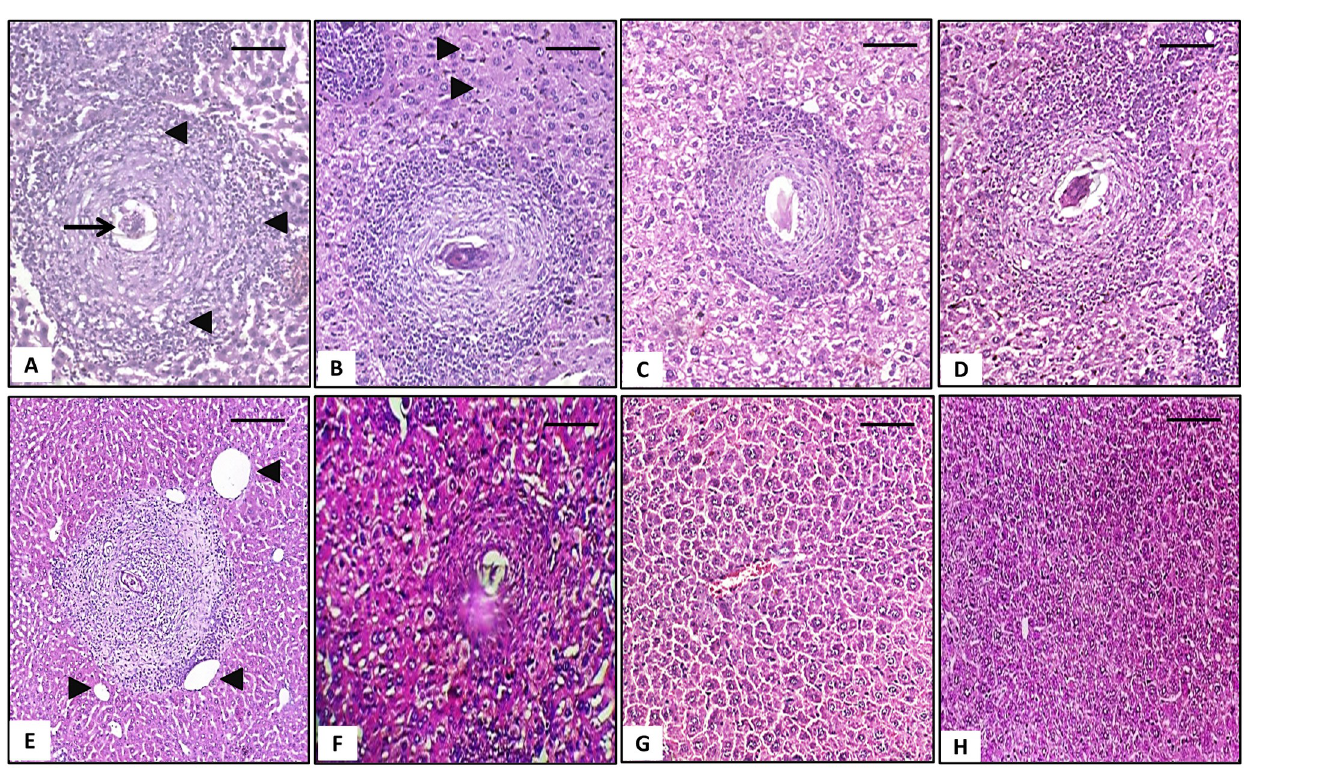
Fig 2. Histopathological liver sections of different S . mansoni -infected groups stained with hematoxylin and eosin ( × 100). A Infected non-treated group showing a large cellular granuloma, composed of inflammatory cellular infiltrate (black arrow head) surrounding central trapped ova (black arrow), B Prophylaxis group showing large granuloma around trapped fresh egg and some vacuolated hepatocytes with cloudy changes (black arrow head), C Ginger treated group showing reduced granuloma size with vacuolated cytoplasm, D GNPs treated group showing significant smaller granuloma size; with less cellular infiltration, E PZQ treated group showing remarkably reduced granuloma size with less inflammatory cellular infiltration surrounded by proliferating fibroblast, normal hepatocytes architecture, congested central vein (arrow head) and moderate congestion of hepatic sinusoids, F PZQ/ GNPs treated group showing decreased size of the granuloma with dilated liver sinusoids, G and H MFQ and MFQ/GNPs treated group showing nearly-preserved liver architecture with intact hepatocytes without any detected eggs or granuloma formation. Bar = 100 μm .